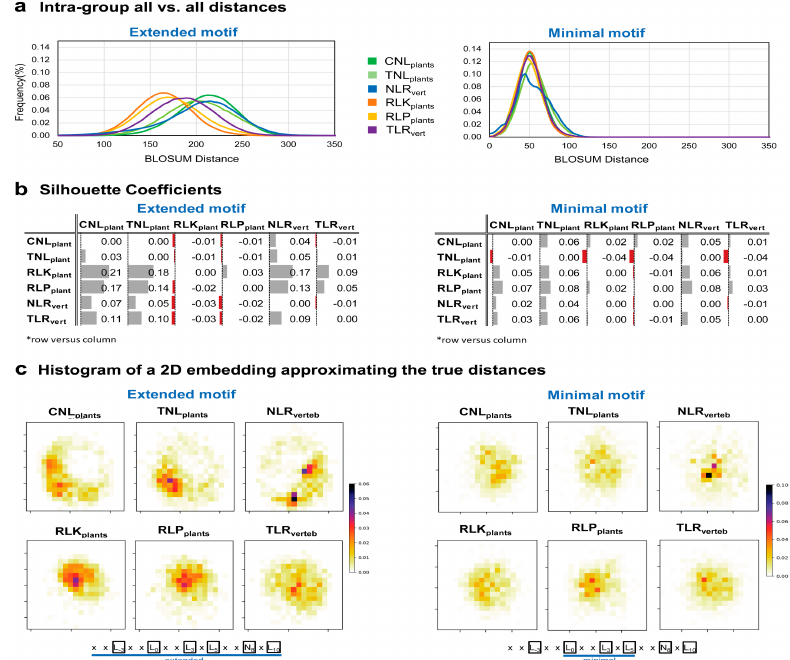
Figure 7. LRR motifs variability in different protein classes. ( a ) Intra-group all-vs.-all distances on the extended (left) and minimal (right) motif ( b ) Silhouette coefficients inter-groups extended (left) and minimal (right) motif. ( c ) Histogram of a 2D embedding approximating the true distances between points for the extended (left) and minimal (right) motif. Histograms were computed using a 20 × 20 bins grid. Extended and minimal motif histograms cannot be compared as they refer to different sequence spaces.